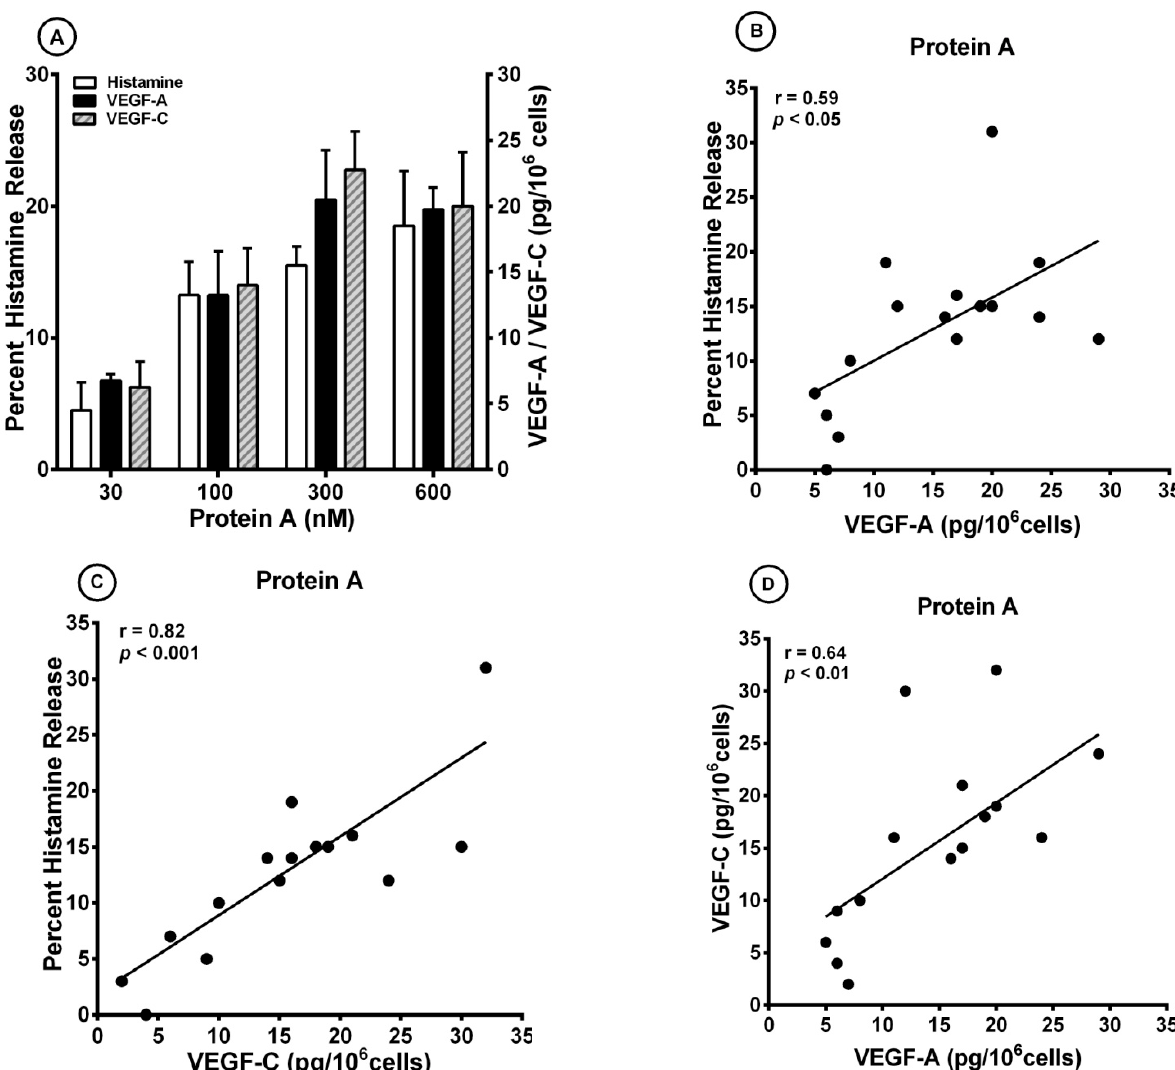
Figure 2. ( A ) Effects of increasing concentrations of protein A on histamine release and the production of VEGF-A and VEGF-C from four different preparations of human lung mast cells (HLMCs). HLMCs were incubated (45 min at 37 ◦ C) with the indicated concentrations of protein A for histamine secretion or (12 h at 37 ◦ C) for VEGF-A and VEGF-C release. Each bar is the mean ± SEM; ( B ) Correlation (r = 0.59; p < 0.05) between VEGF-A release and the percent histamine secretion caused by protein A from HLMCs; ( C ) Correlation (r = 0.82; p < 0.001) between VEGF-C release and the percent histamine secretion caused by protein A from HLMCs; ( D ) Correlation (r = 0.64; p < 0.01) between VEGF-A and VEGF-C release caused by protein A from HLMCs from HLMCs.